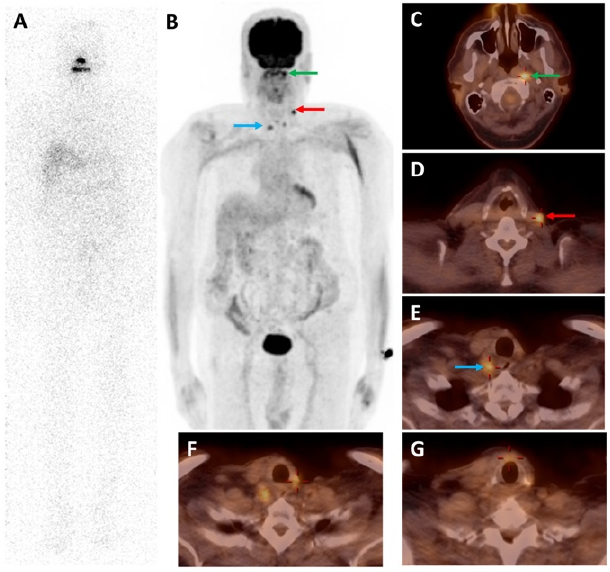
Figure 2. A 70-year-old man with PTC and nodal metastasis was treated with surgery and 131 I therapy (cumulative dose of 600 mCi). ( A ) The last post-therapeutic 131 I WBS was negative despite elevated serum Tg. [ 18 F]FDG MIP skull-to-mid-thigh PET ( B ) and axial fused PET/CT ( C – G ) images showed [ 18 F]FDG-avid lesions in left retropharyngeal (( C ), green arrow), left cervical (( D ), red arrow), and right cervical (( E ), blue arrow) lymph nodes, and thyroidectomy bed ( F , G ). All are suggestive of RAI-refractory disease.